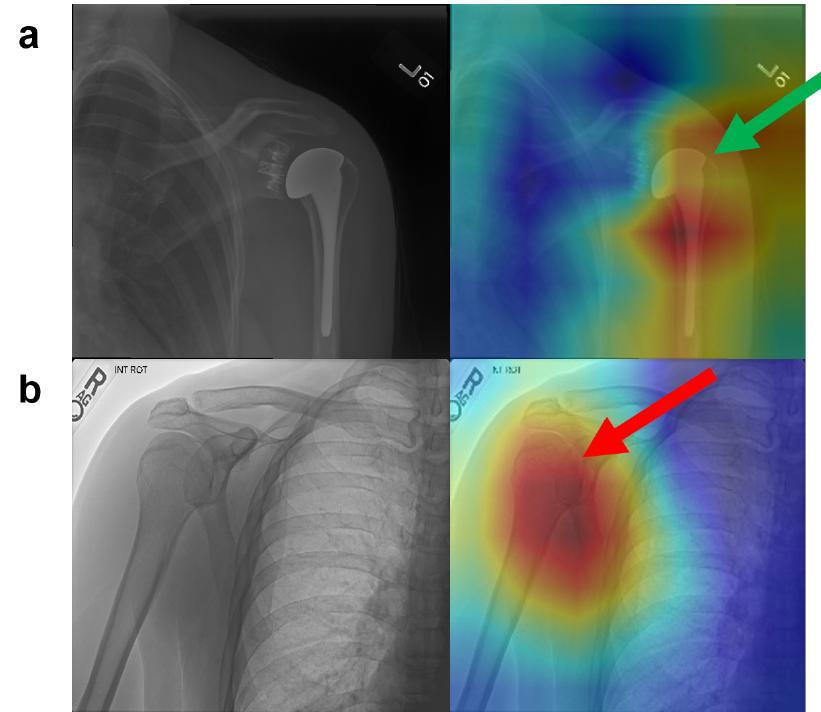
Figure 5. Examples of heatmaps for the shoulder’s radiographys predicted by the proposed framework. ( a ) is an abnormal sample where the green arrow on the right pointed to the salient features corresponding to model’s correct prediction. ( b ) is a normal sample where the red arrow on the right pointed to the salient features corresponding to the model’s wrong prediction. Table 3. Kappa statistic score obtained by DenseNet169, CapsNet and